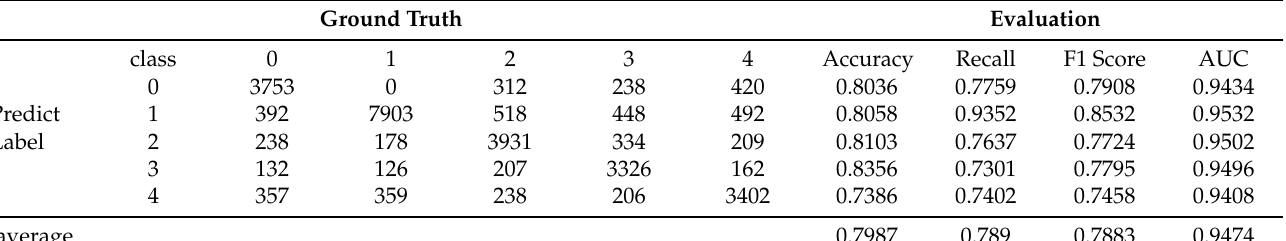
Table 3. Different cases of recognition.